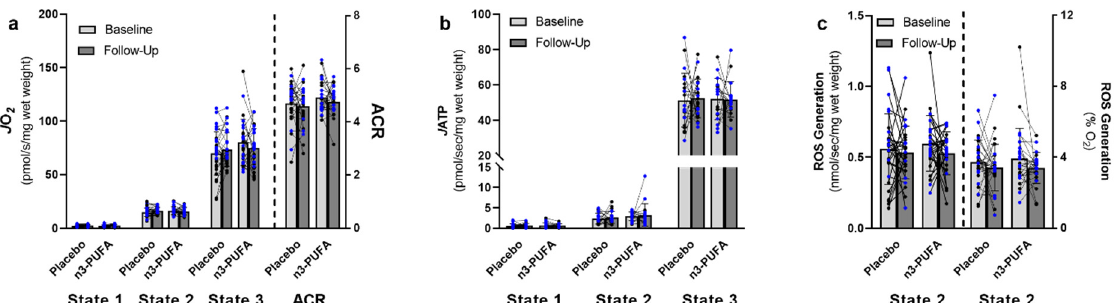
Figure 3. The effects of 6-months placebo or n3-PUFA on skeletal muscle mitochondrial function. Skeletal muscle mitochondrial function was evaluated by measuring ( a ) mitochondrial respiration (placebo: n = 30; n3-PUFA: n = 27), ( b ) ATP production (placebo: n = 20; n3-PUFA: n = 17), and ( c )